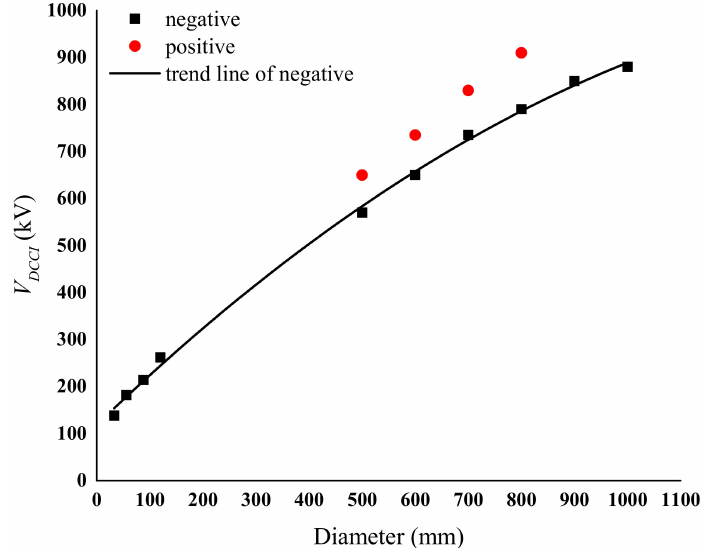
Figure 10. V DCCI according to the diameter of the electrode